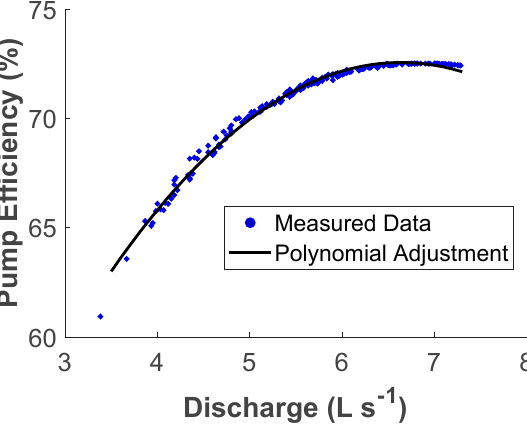
Figure 8. Efficiency of the pump for at different rotational speed.